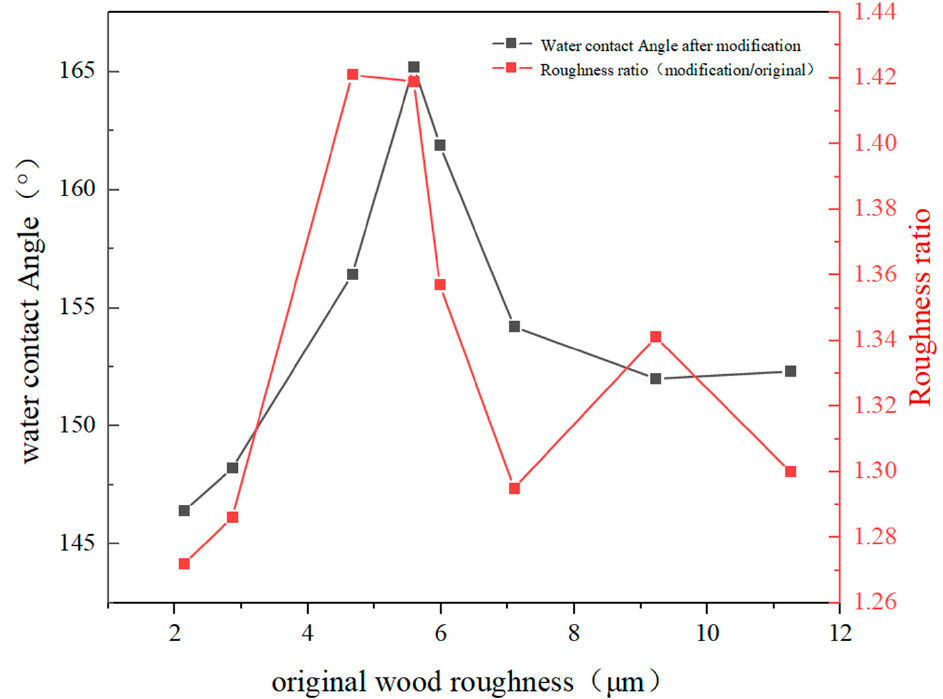
Table 2. Original wood density, porosity, and roughness.